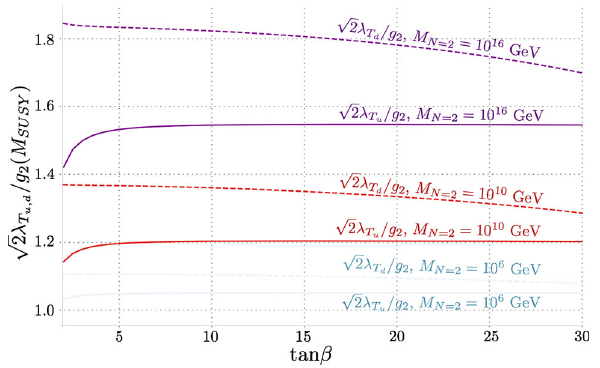
√ / g against tan β at the M 2 λ T Fig. 12 Z 6 ( Q ) against tan β for a Higgs mass of 125 GeV at m t , for SUSY u , d values of M (cid:12) = 5, 100 M SUSY and M N = 2 = 10 6 and 10 16 GeV